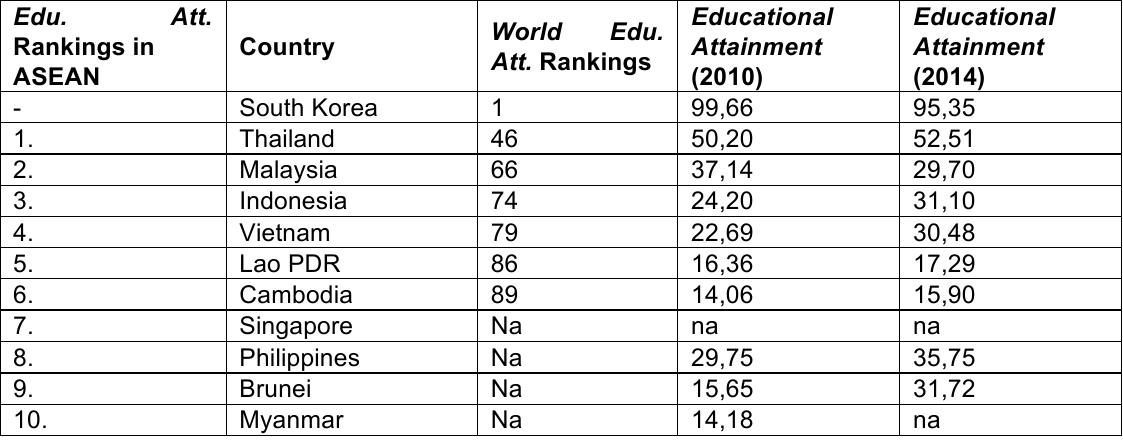
Table 8: The number of Educational Attainment (% of national workforce) Edu.